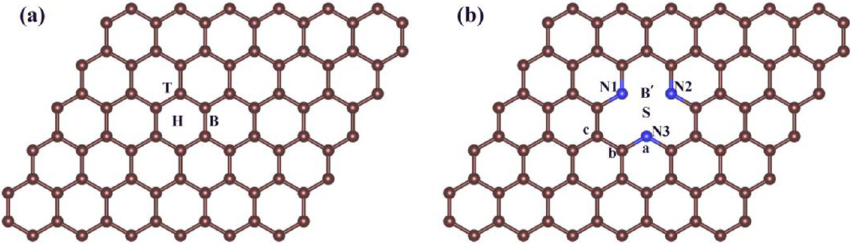
Figure 1. Color code: C, black; N, blue. ( a ) the three different adsorption sites (H (hollow), B (bridge), T (top)) in pure graphene; ( b ) in the SVGN3: a stands for the top position of nitrogen, b and c stand for the top positions of carbon at different positions; B’ stands for the bridge position between two nitrogen atoms; The symbol S represents the single vacancy in the substrate. The three nitrogen atoms are labeled as N1, N2, and N3, respectively.